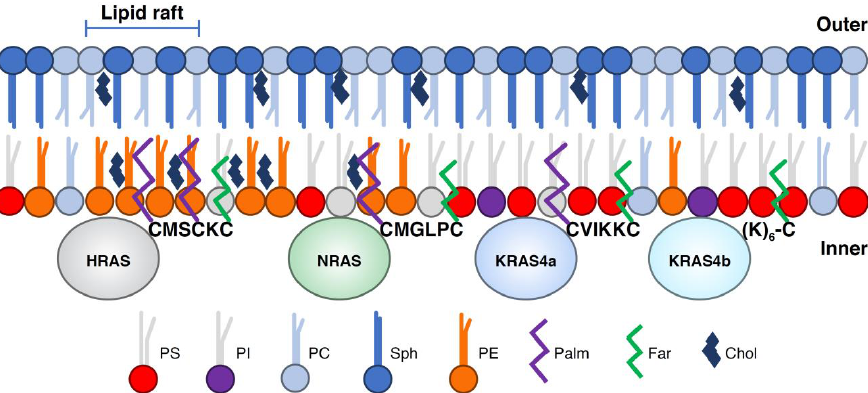
Figure 5. RAS HVR defines membrane localization. Cartoon representation showing how differences in the amino acid sequence and lipid modification of the HVR of RAS isoforms determine plasma membrane localization. Plasma membrane lipids are represented as phosphatidylserine (PS), phosphatidylinositol (PI), phosphatidylcholine (PC), phosphatidylethanolamine (PE), sphingolipids (Sph) and cholesterol (Chol). Lipid modifications on RAS proteins are shown as palmitoylation (Palm) and farnesylation (Farn). This figure was motivated by a similar representation described in